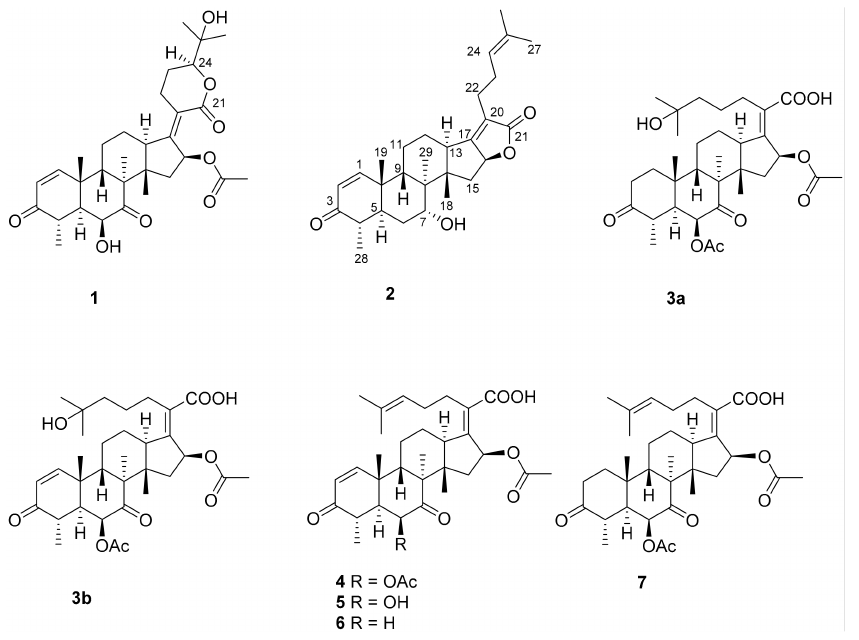
Figure 1. The chemical structures of compounds 1 – 7